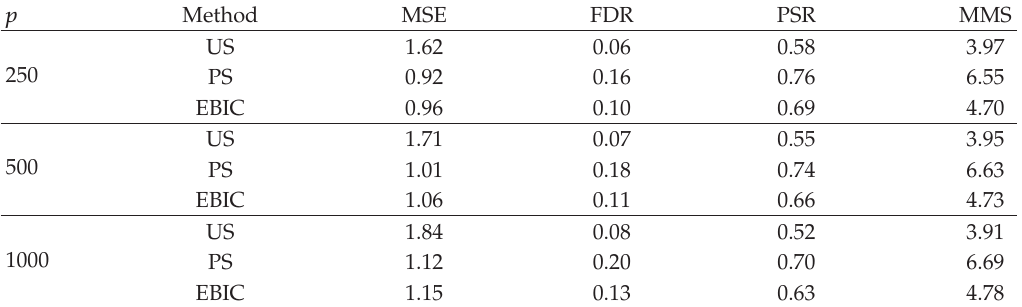
Table 1: Simulation results for variable selection in the Cox model with parametric relative risk.